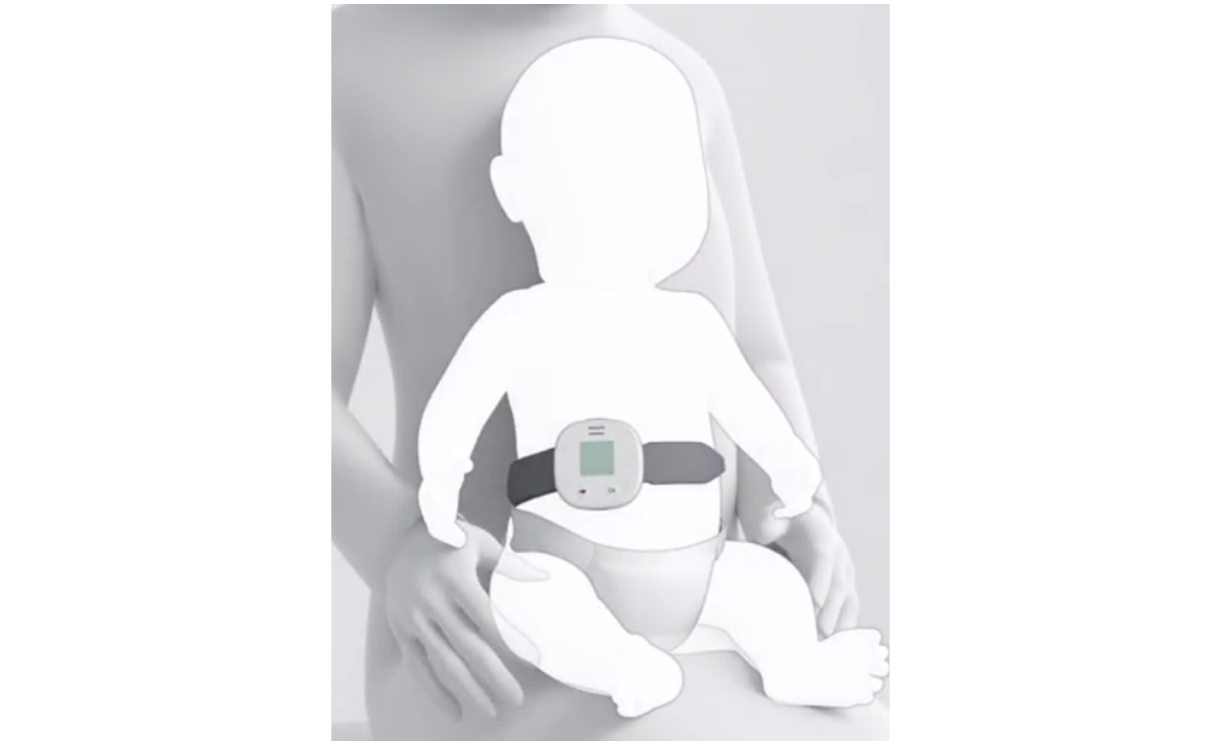
Figure 1. Illustration of the Philips ChARM device positioned on a